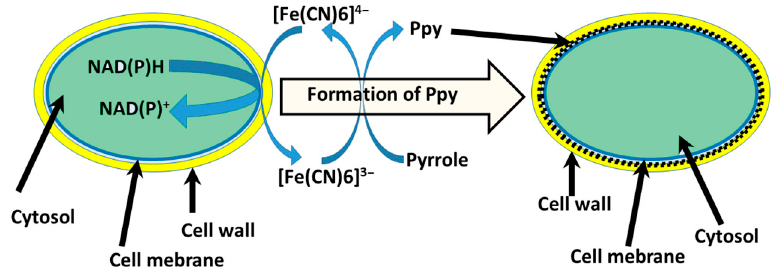
Figure 5. Schematic representation of PPy synthesis in the cell wall of yeast [13]. Redox enzymes located in the plasma membrane oxidize [Fe(CN) 6 ] 4 − into [Fe(CN) 6 ] 3 − and induce a polymerization reaction of pyrrole [95].